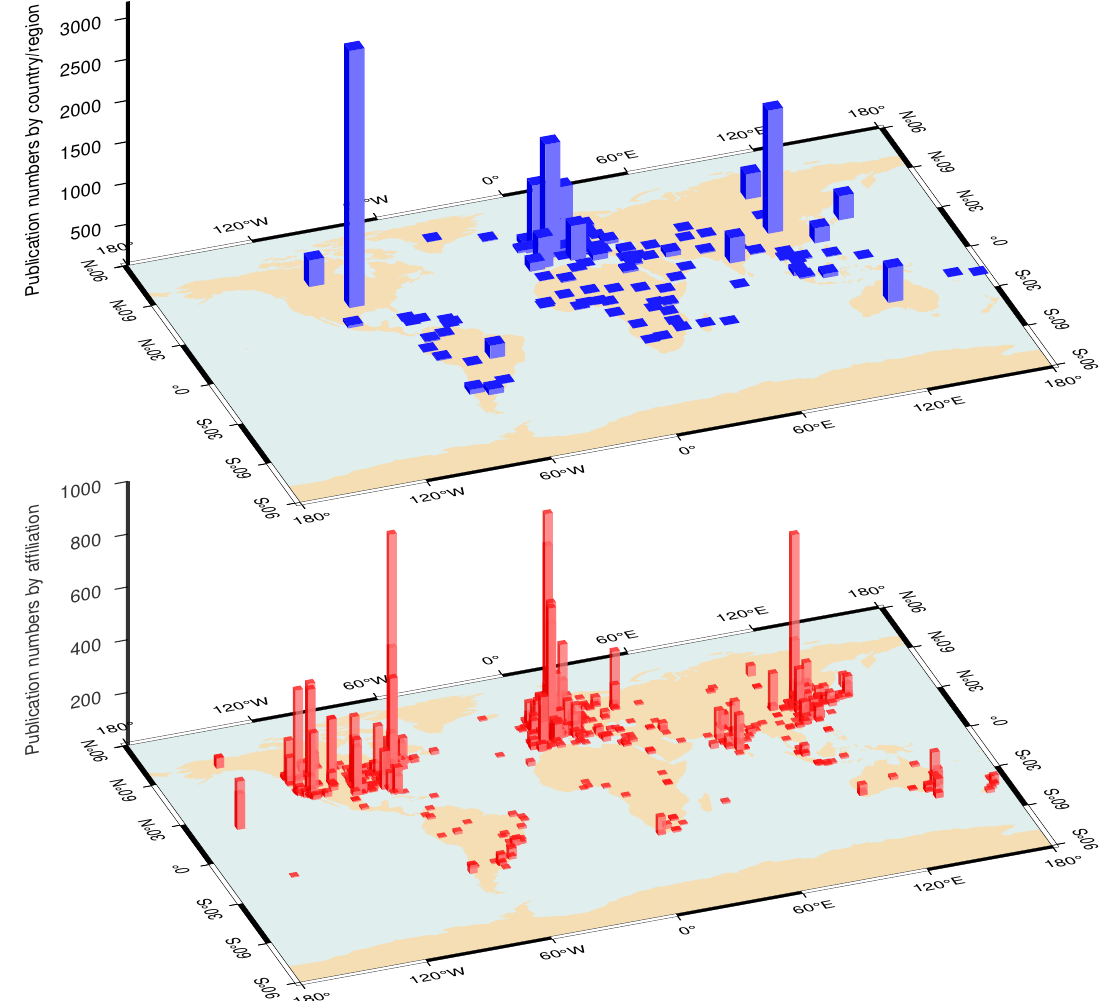
Figure 5. Geographic distribution of the satellite altimetry literature by category of country/region ( top ) and affiliation ( below ) based on the WoS data of 1970 to 2021. The bar height indicates the number of